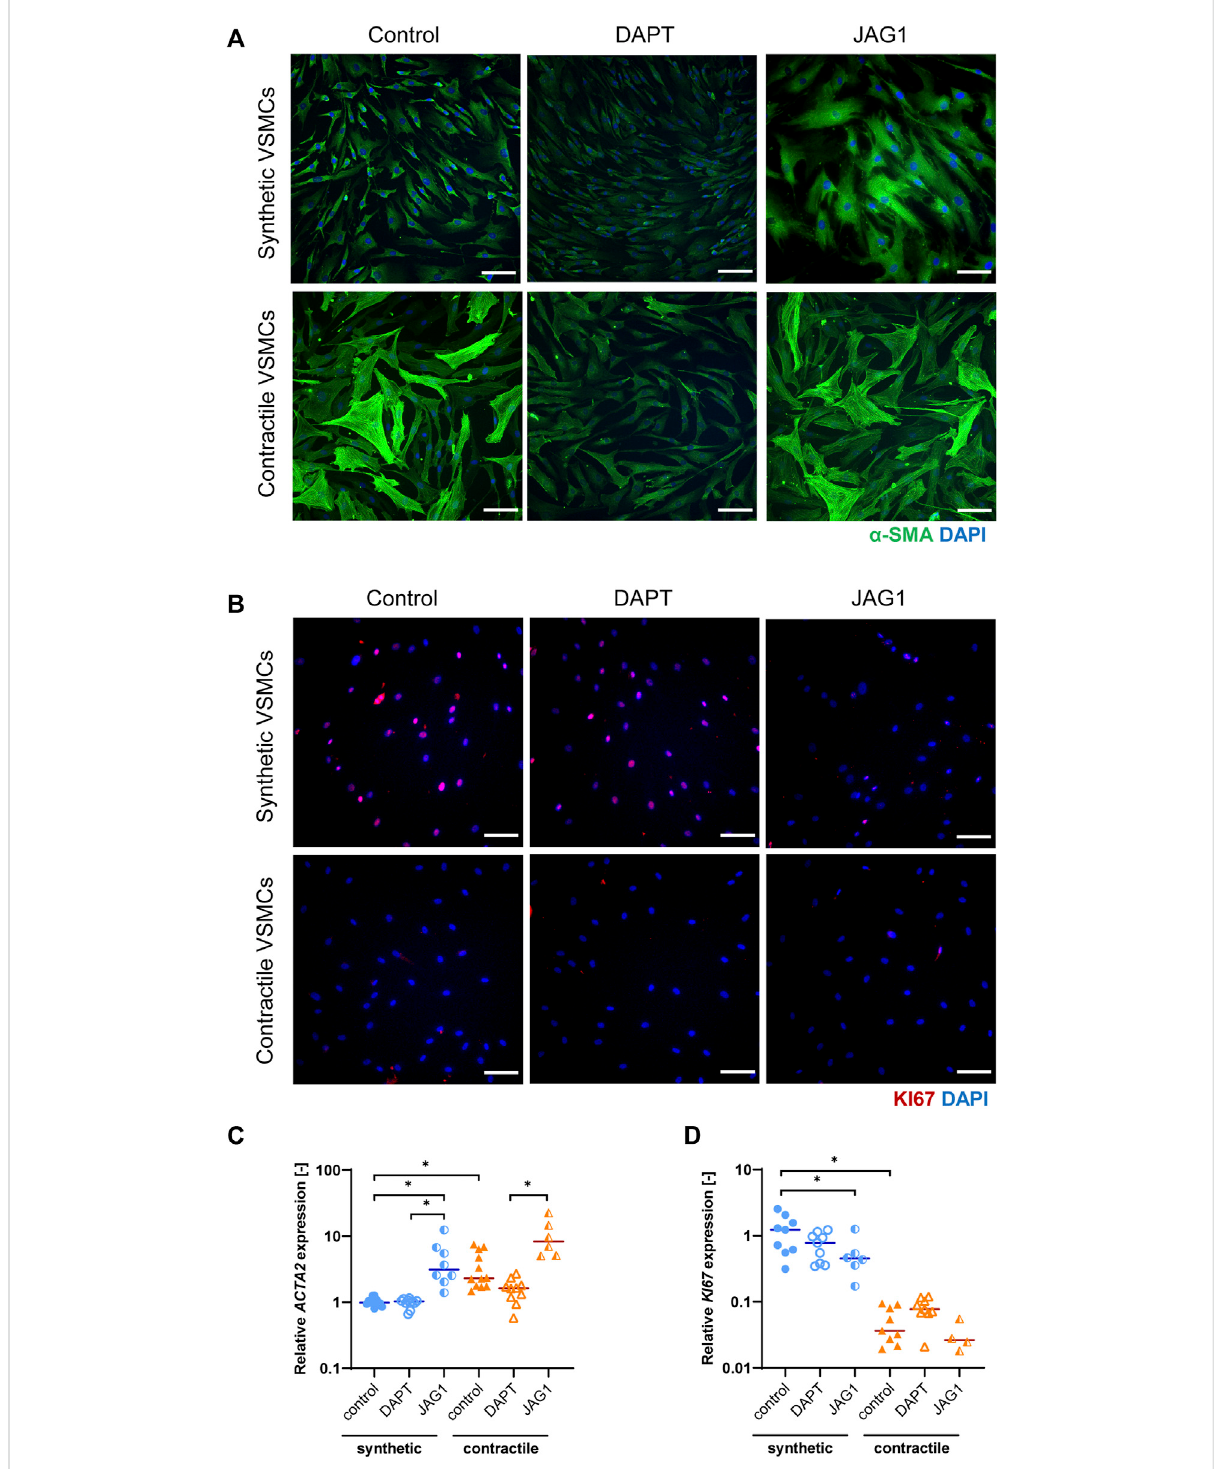
FIGURE 2 Characterization of synthetic and contractile VSMCs, and the impact of Notch signal inhibition and activation on VSMC phenotype. Representative IF images of (A) α SMA in green and nuclei in blue, (B) KI67 in red and nuclei in blue for control, DAPT-treated and JAG1-induced synthetic and contractile VSMCs (scale bar: 100 μ m). Gene expression of phenotype markers (C) ACTA2 and (D) KI67 normalized to the synthetic control condition (* p < 0.05